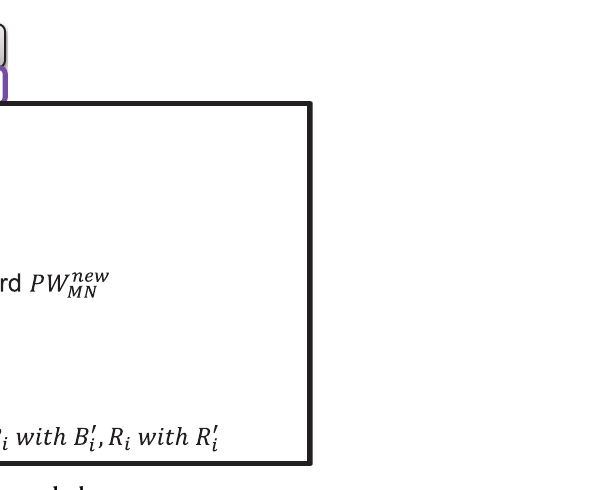
Fig 9. Password change phase of proposed